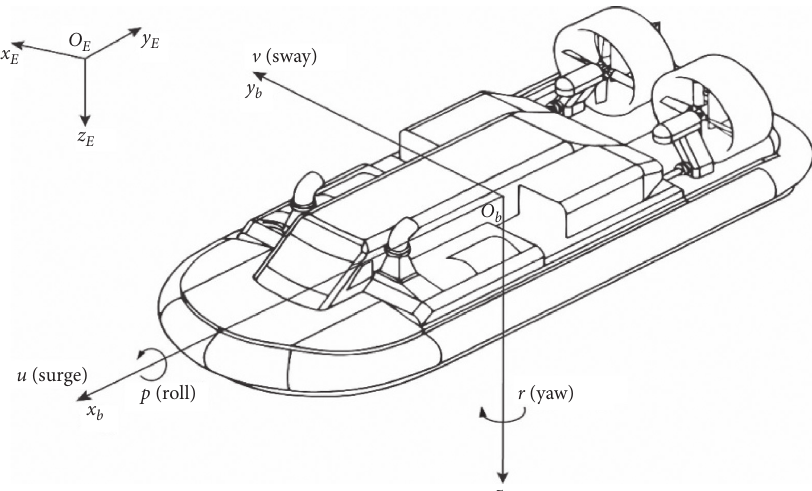
Figure 1: Reference frame of the